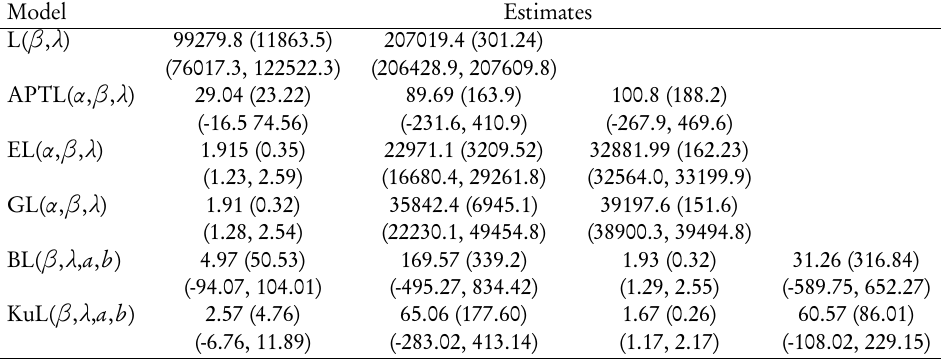
MLEs, standard errors (in parentheses) and the CIs for the fitted distributions based on data set